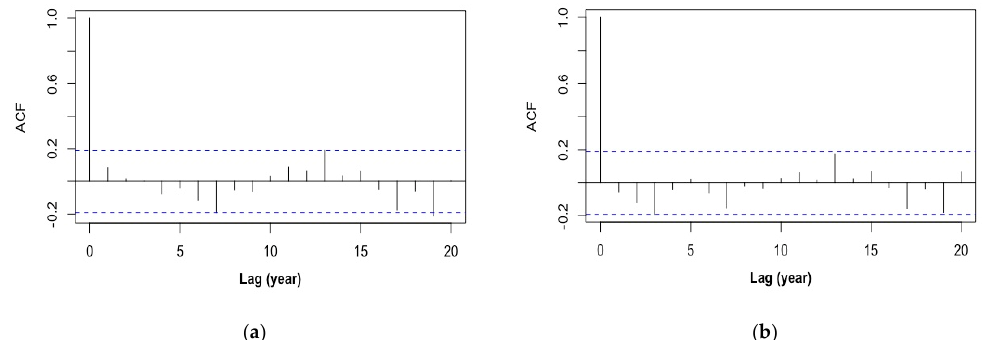
Figure 4. Autocorrelation function (ACF) plots of model residuals for ( a ) MA (1) and ( b ) AR (2). Blue dashed lines denote the 95% confidence intervals.